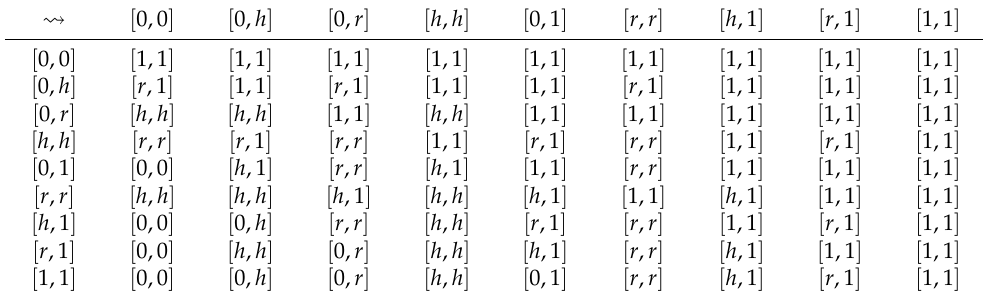
Table 3. The operator (cid:32) of algebra in Example